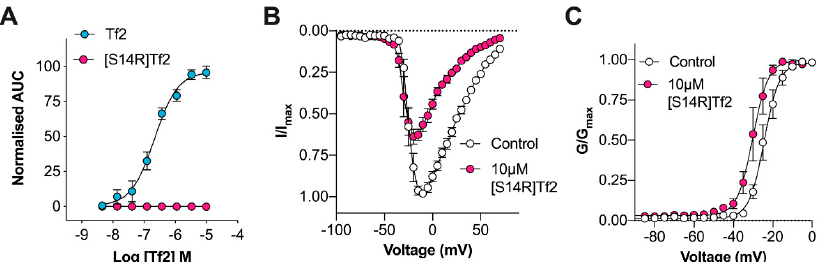
did not activate hNa V 1.3 in a fluorescence-based membrane potential assay (Figure 2A). In patch-